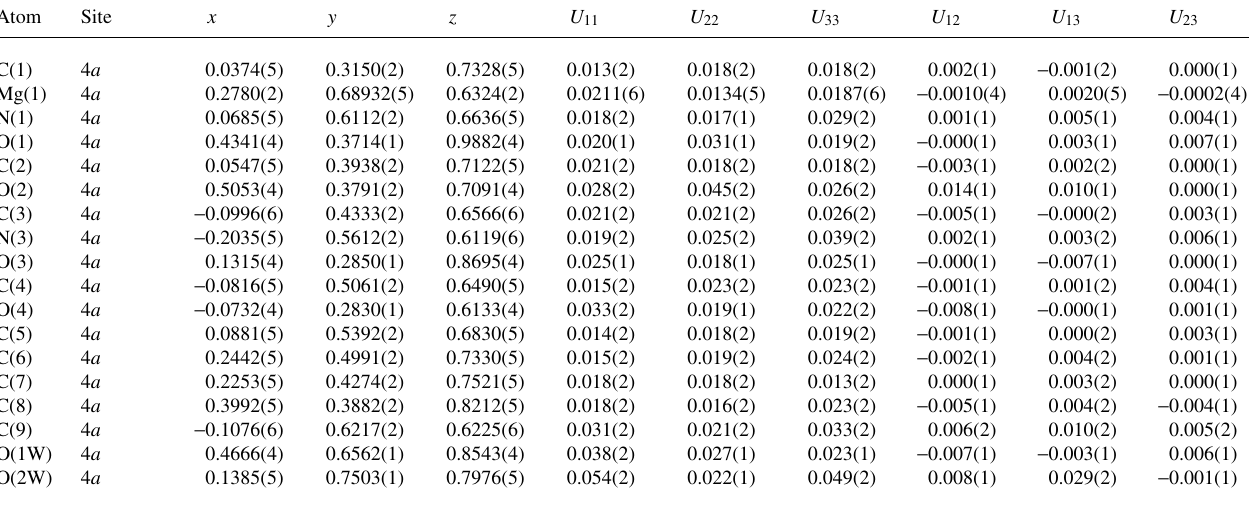
Table 3. Atomic coordinates and displacement parameters (in Å 2 )